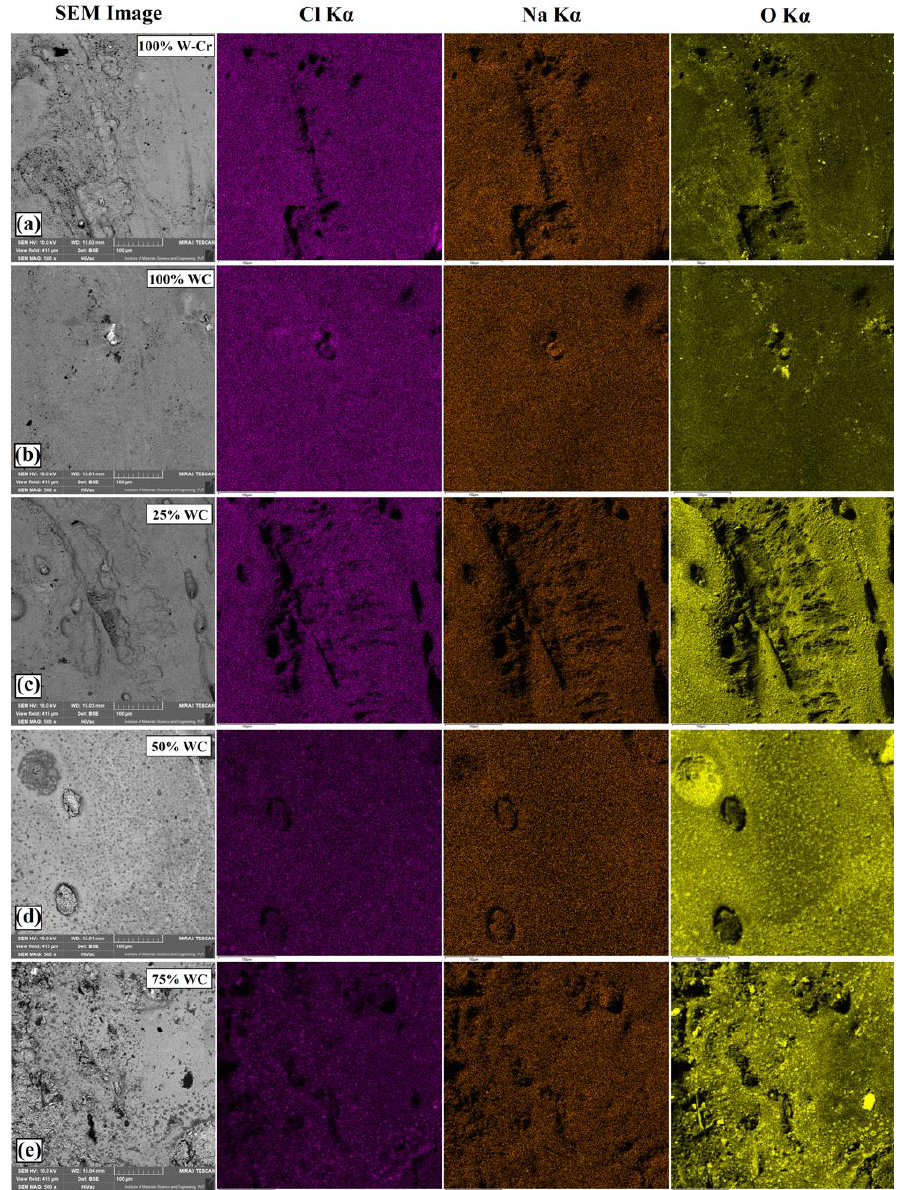
Figure 14. Macroscopic images of the surface condition after corrosion tests and EDS mapping for the following coatings: ( a ) W–Cr; ( b ) 100% WC; ( c ) W–Cr / 25% WC; ( d ) W–Cr / 50% WC; ( e ) W–Cr / 75%